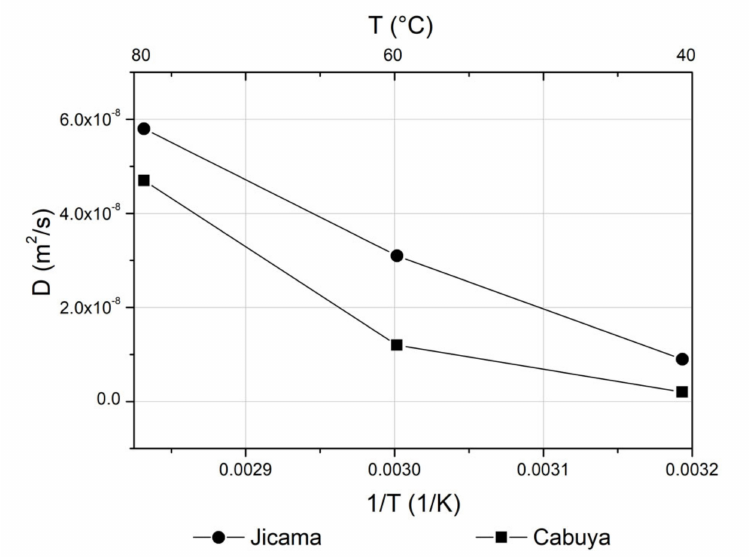
Figure 4. Arrhenius plots of the e ff ective di ff usion coe ffi cients for jicama and cabuya.